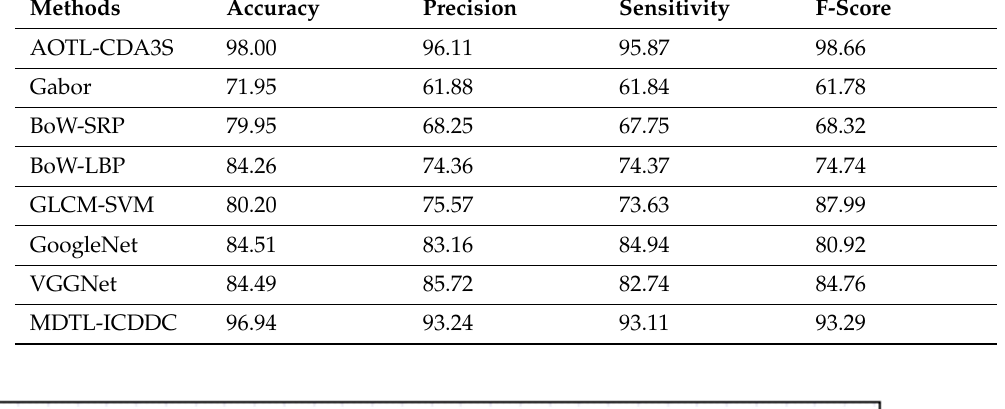
Table 5. Comparative analysis of the AOTL-CDA3S system with recent approaches.